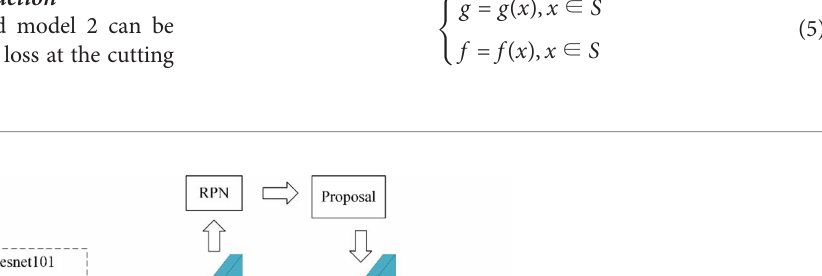
Figure 7 . Afterward, the tumor boundaries were extracted and mapped to the original image coordinate, as shown in step ④ .